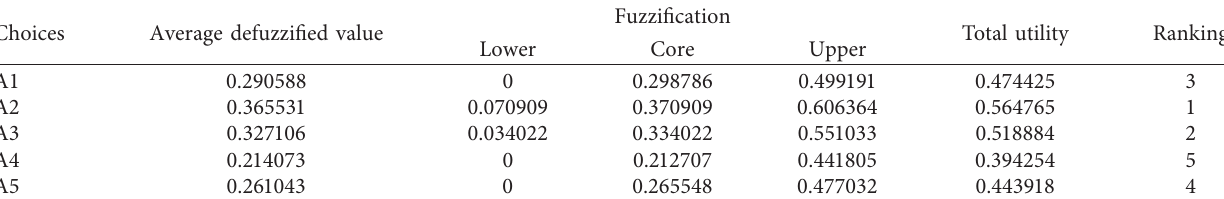
Table 13: Ranking